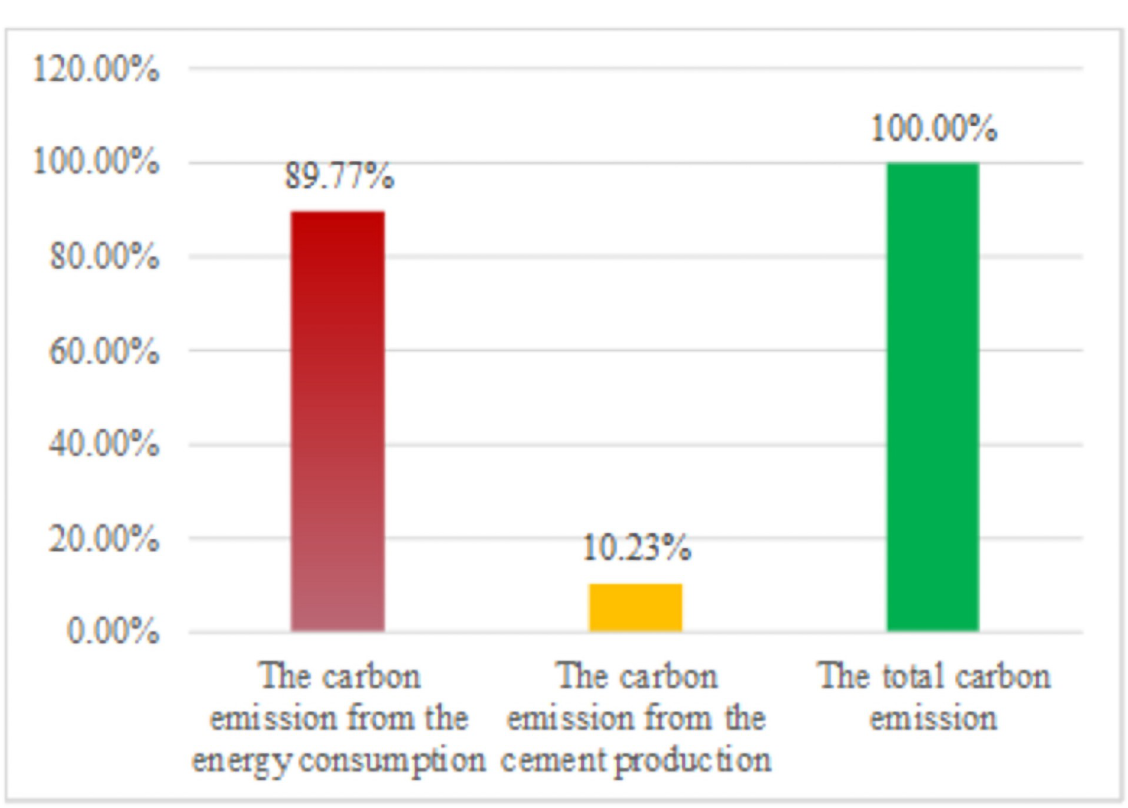
Fig 2. The share of carbon emissions from energy consumption and cement production.